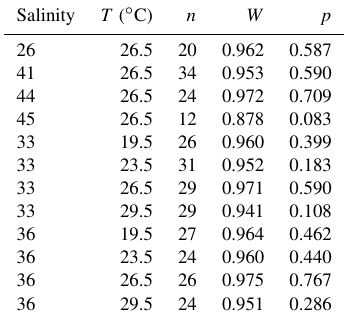
Table A1. Na / Ca values generated for each experiment were tested for normality with the Shapiro–Wilk W test and its corresponding p value. If p is ≥ 0 . 05 (95% confidence interval), the data are normally distributed. The number of measurements is indicated with n . Salinity and temperature ( T ) values derive from the culture experiments listed in Tables 3, 4, and 5.